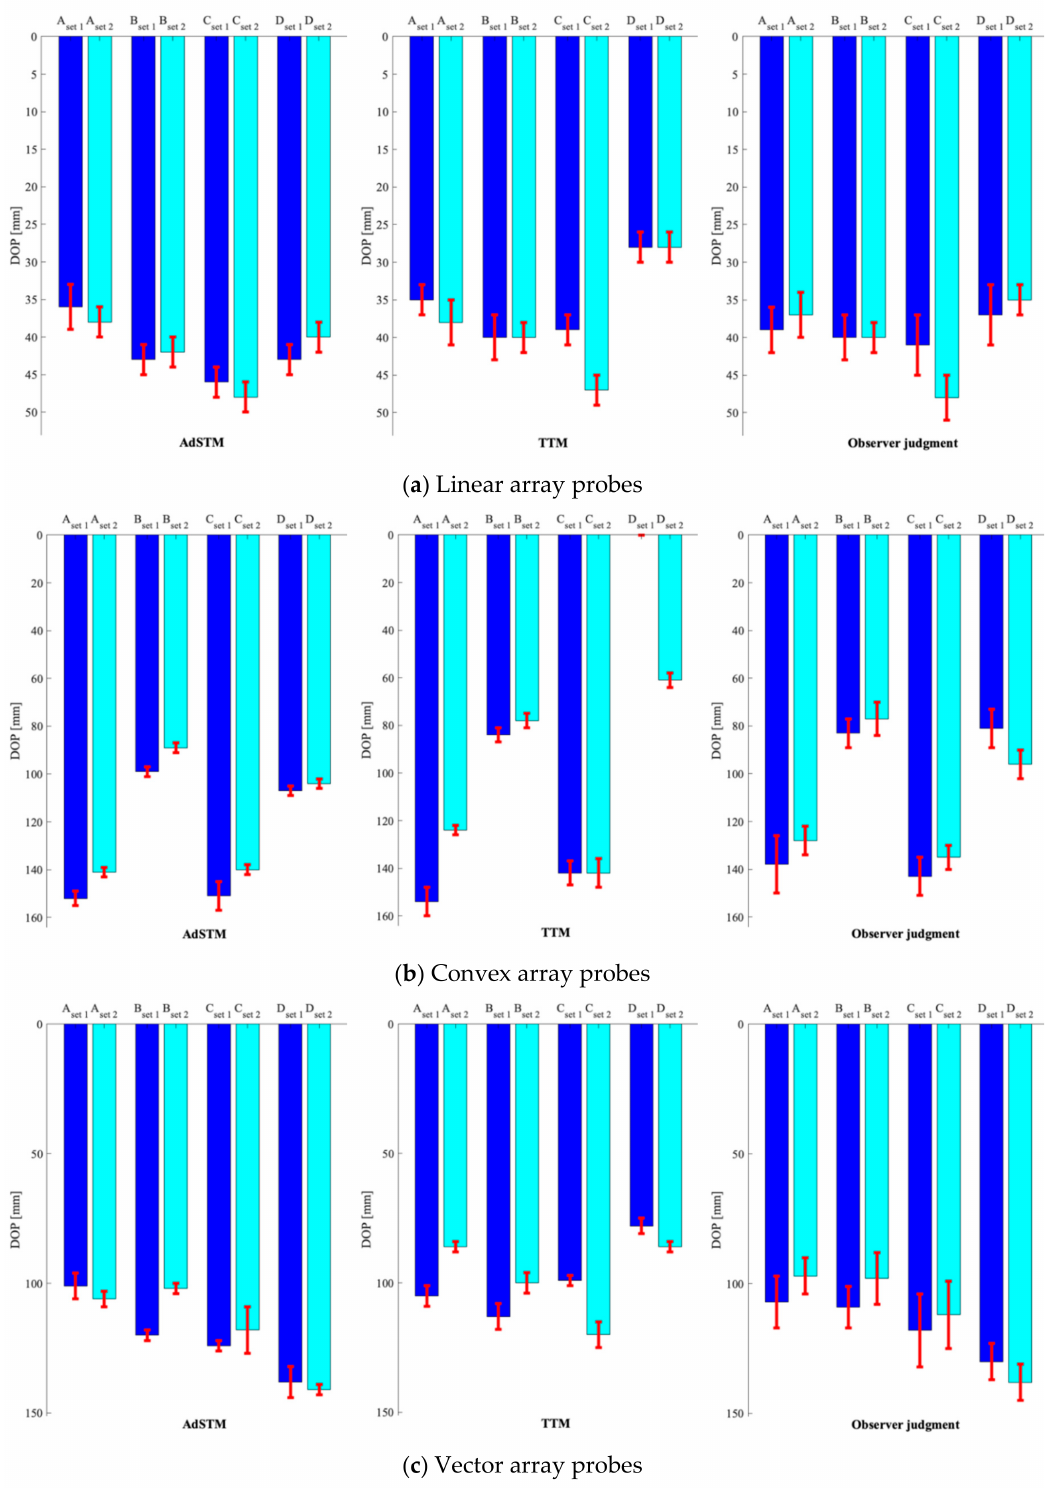
Figure 3. Depth of penetration outcomes retrieved from the AdSTM, the TTM, and observer judgment for ( a ) linear, ( b ) convex, and ( c ) vector array probe